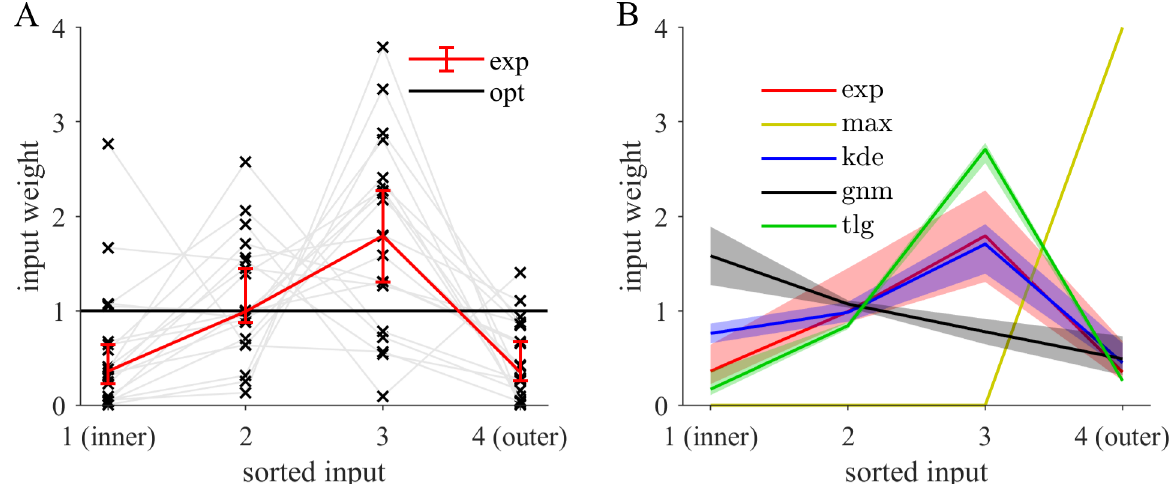
Fig 5. The weighting pattern of the observed samples deviates from inference of a close-to-normal distribution and matches kernel density estimation (KDE). Evaluation of the normalized weights ω zero centered Gaussian. The points are indexed according to their distance from the center. (A) Input weight that each participant (gray lines) assigns as a function of the weight index. If participants followed optimal MLE based on a Gaussian centered at zero, all input weights should be equal (black line). Fitting of the weighting model (see Methods) shows a systematic deviation of the across participant median (red, error bars, 95% CI). Participants tend to overweigh the third most extreme value compared to the others. (B) Among all models tested, only KDE (blue) qualitatively matches the characteristics of the experimental weighting pattern (red, same as panel A). The other models fail to capture the behavioral weighting pattern (fits of the weighting model to the other indicated models’ output). Model abbreviations: kde—kernel density estimation, tlg—tiling, gnm—generalized normal,